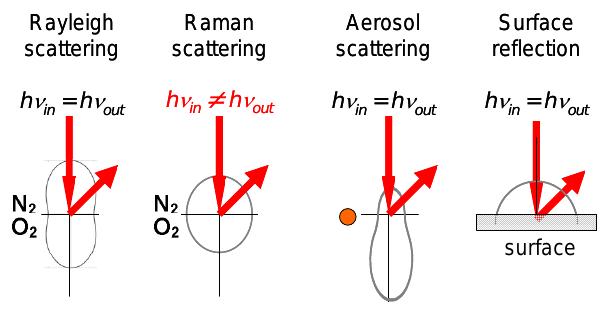
Fig. 4 Angular dependence of different types of scattering and reflection. Compared to Rayleigh scattering and aerosol scattering the angular dependence of rotational Raman scattering is weak. Thus, for a scattering angle of 90° the relative contribution of Raman scattering (and thus the Ring effect) is strongest.